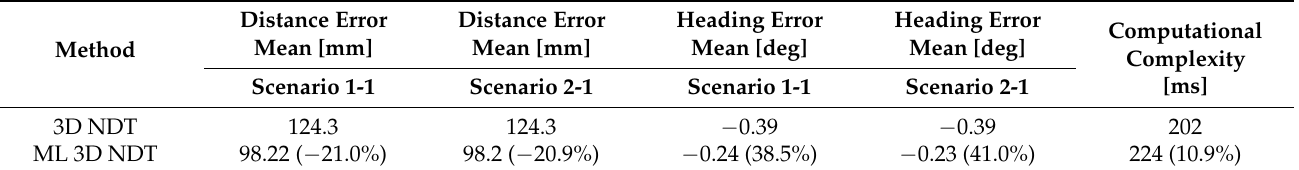
Table 2. Result of the comparative study of 3D NDT and ML 3D NDT in scenario 1-1 and 2-1. Table 1. Internal parameters of ML-3D NDT scan-matching with three layers.